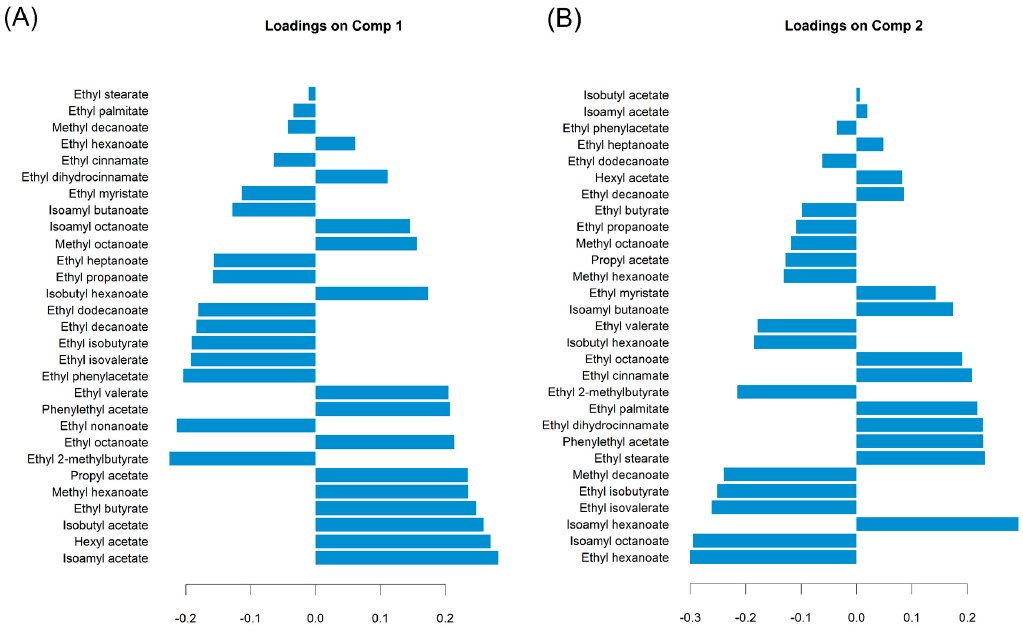
Figure 2. Loadings bar plot on component 1 ( A ) and component 2 ( B ) of the principal component analysis carried out on the brandy